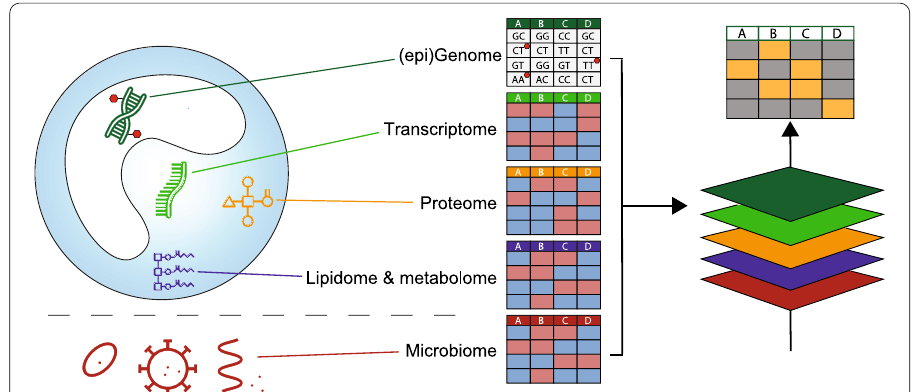
Fig. 1 Schematic overview of different molecular layers measured by -omics technologies. Integrating these layers through multi-omics analysis can yield a more holistic view of biological processes and uncover novel connections between